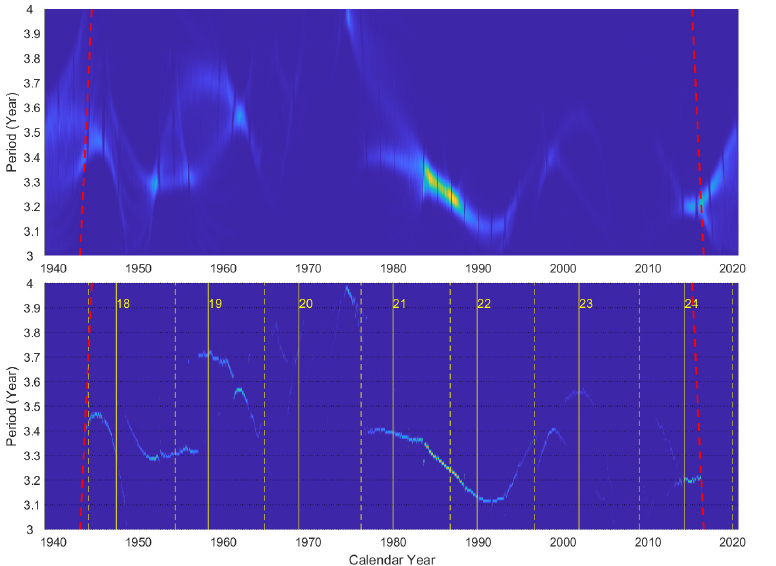
Figure 9. Same as Figure 6, but for periods between 3 and